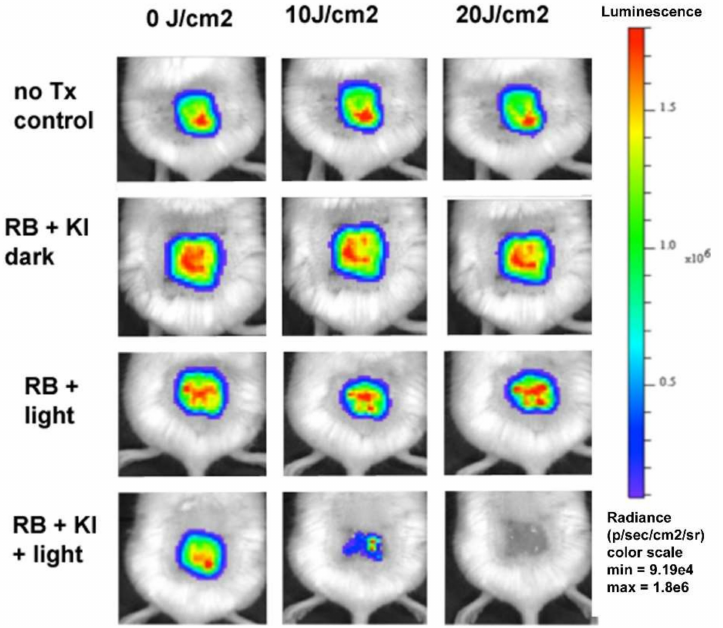
Figure 10. PDT using Rose Bengal plus potassium iodide can eradicate P. aeruginosa in a mouse infection model. Figure reproduced from [29], open